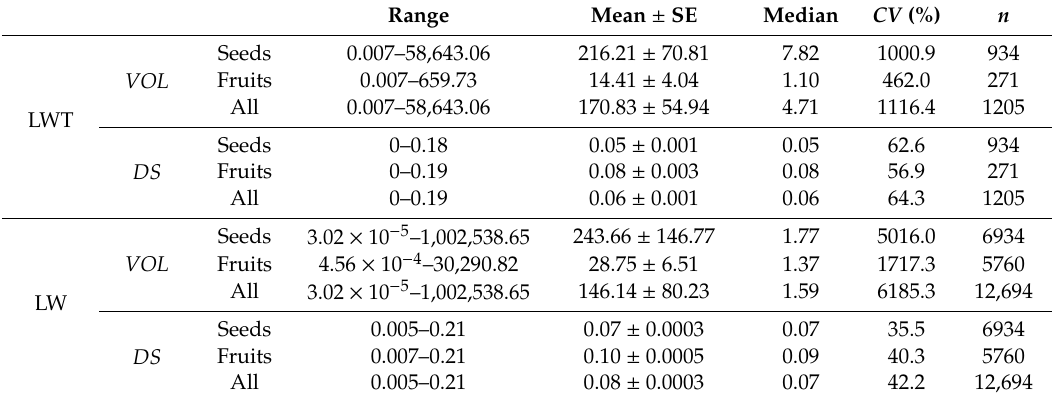
Table 1. Range, mean ± SE, median, coe ffi cient of variation ( CV ), and sample size ( n ) of volume ( VOL , in mm 3 ) and departure from sphericity ( DS ) of seeds, fruits, and of seeds and fruits